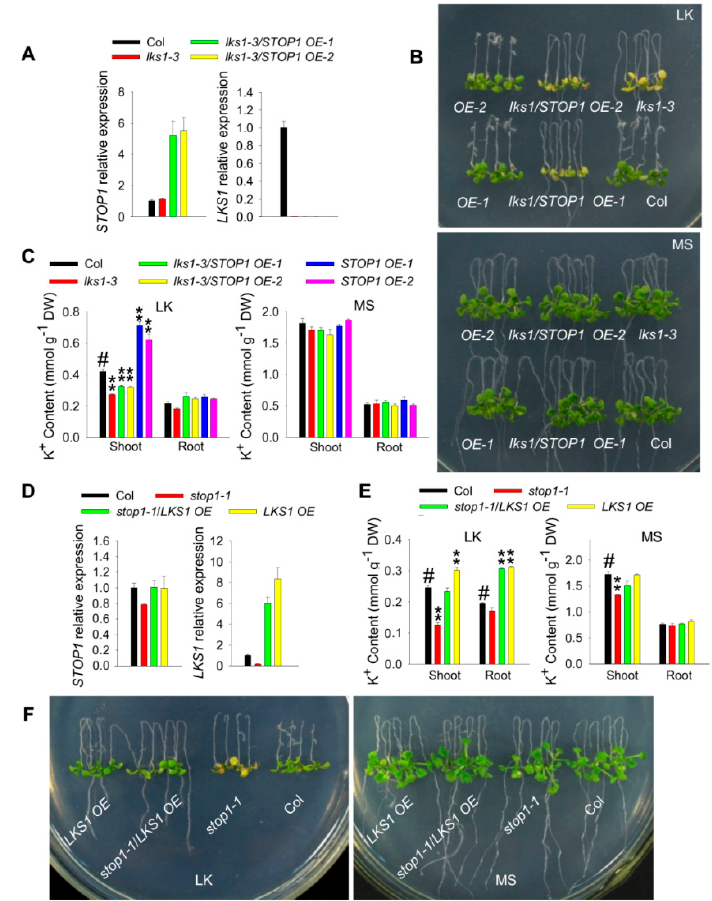
Figure 4. STOP1 acts upstream of LKS1. ( A ) RT-qPCR analyses of STOP1 (left) and LKS1 (right) expression in the roots of various plants. Data are presented as means ± SE ( n = 3). ( B ) Phenotype comparison of wild type (Col), lks1-3 , STOP1 OE ( OE-1 and OE-2 ), and lks1-3 / STOP1 OE ( lks1 / STOP1 OE-1 and lks1 / STOP1 OE-2 ). The 5 day old seedlings were transferred to MS or LK medium for 10 d. ( C ) K + content measurement of indicated plants shown in ( B ) after being transferred to MS or LK medium for 7 days. Data are shown as means ± SE ( n = 3). Student’s t -test (** p < 0.01) was used to analyze statistical significance; # represents the control. ( D ) RT-qPCR analyses of STOP1 (left) and LKS1 (right) expression in the roots of tested materials as indicated. Data are presented as means ± SE ( n = 3). ( E ) K + content measurement of indicated plants shown in ( F ) after being transferred to MS or LK medium for 7 days. Data are shown as means ± SE ( n = 4). Student’s t test (** p < 0.01) was used to analyze statistical significance; # represents the control. ( F ) Phenotype comparison among stop1-1/LKS1 OE , stop1-1 , LKS1 OE , and wild-type plants . The 5 day old seedlings were transferred to MS or LK medium for 10 days.